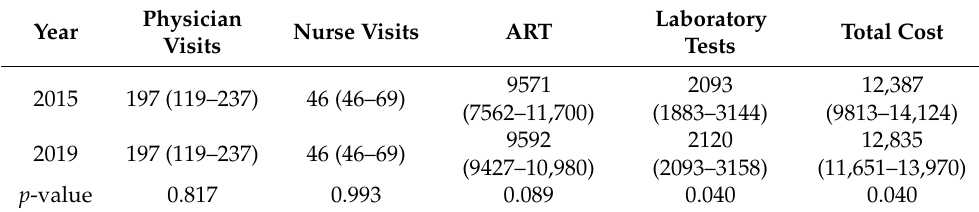
Table 2. Median (IQR) costs ($) per HIV patient per year.